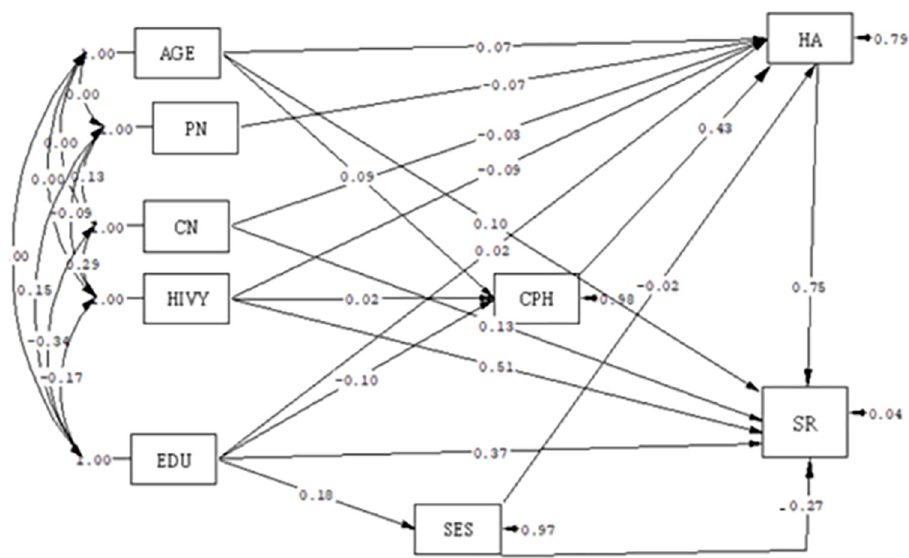
Fig 2. Full empirical model (Empirical path model between health anxiety, corona phobia, and social relations) according standard B. AGE = age of the participants, PN = partner number, CN = Child Number, HA = Health anxiety, HIVY = HIV duration, EDU = Education, CPH = COVID-19 phobia, SES = Socioeconomic statues, SR = Social relation.